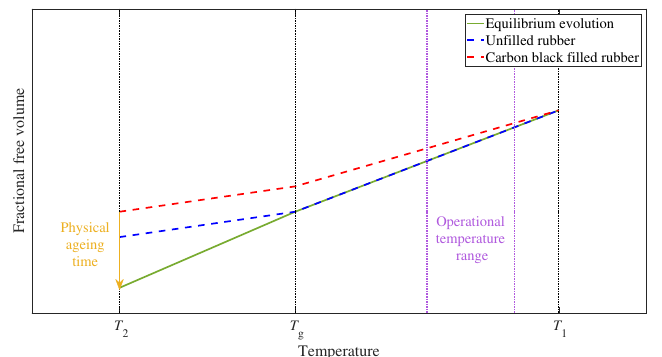
Figure 1. Schematic representation of the free volume evolution after a temperature change from T 1 to T 2 , below T g . The equilibrium evolution is plotted as a solid green line, the evolution for unfilled rubber is plotted as a dashed blue line and the evolution for filled rubber is plotted as a dashed red line. The violet band indicates the operational temperature of rubber for a wide variety of applications, where a deviation from equilibrium is observed for filler reinforced